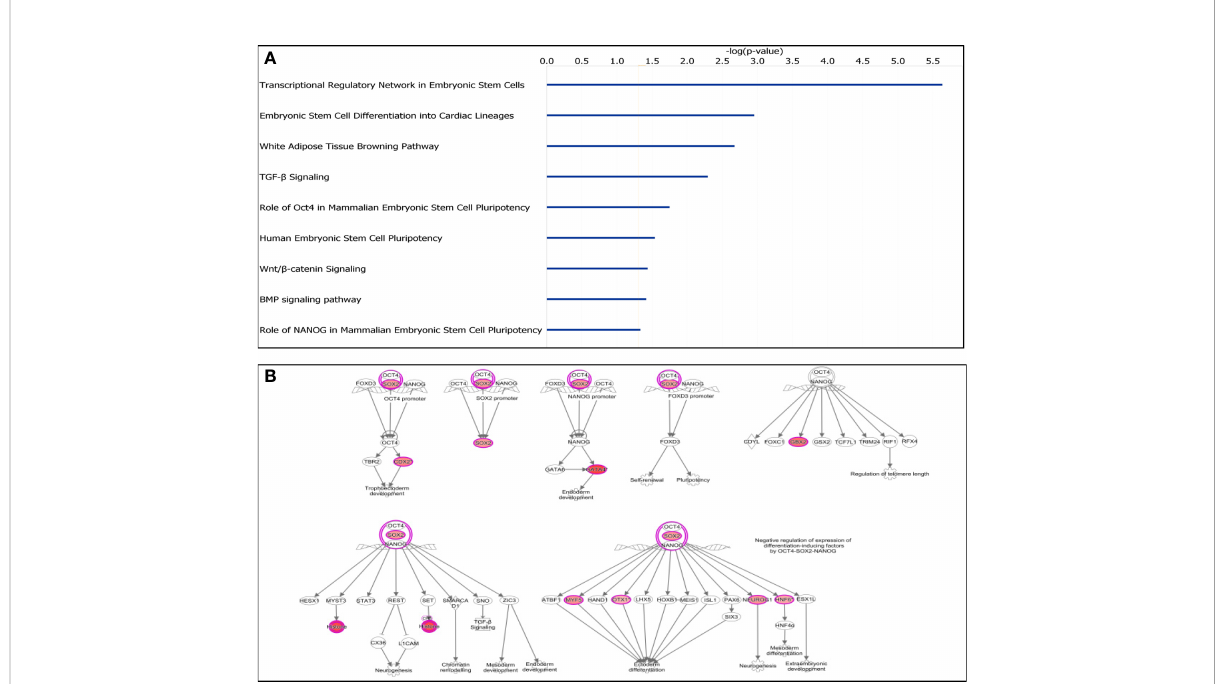
FIGURE 3 Characterization of differentially methylated CpG islands. (A) Top signi fi cantly affected canonical pathways. Transcriptional Regulatory Network in Embryonic Stem Cells was the highest ranking enriched canonical pathway. (B) IPA analysis of transcriptional regulatory network in embryonal stem cells. Nine stem cell related genes were all hypermethylated (in